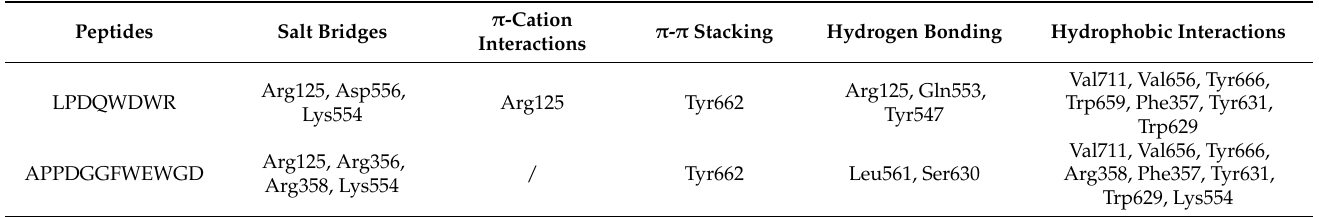
Table 2. The interaction types and amino acid residues of the synthesized peptides with dipep- tidyl